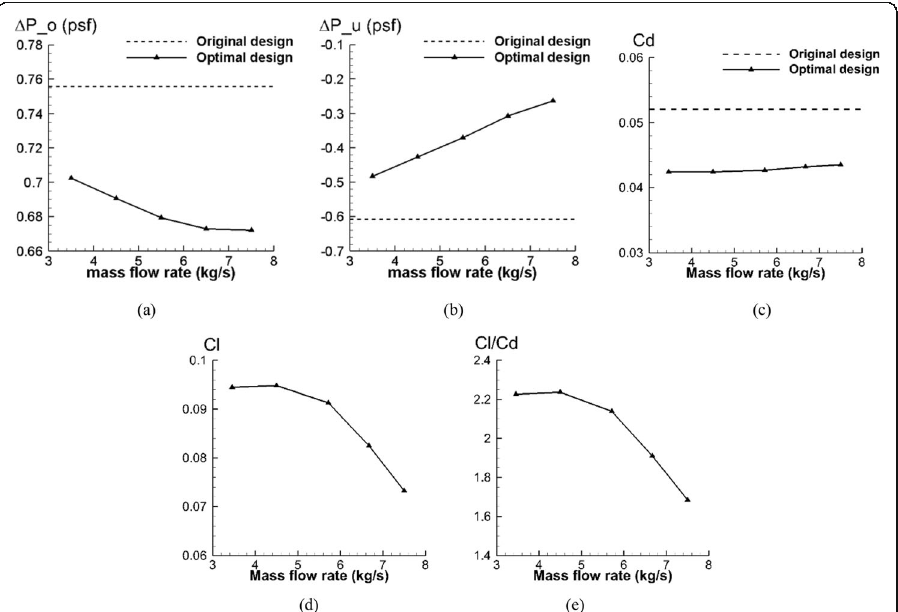
Fig. 13 The ground boom signatures and drag coefficients for the baseline and optimized NACA0008 airfoil with different mass flow rates. a the maximum overpressure vs the mass flow rate; b the maximum underpressure vs the mass flow rate; c the drag coefficient vs the mass flow rate; d the lift coefficient vs the mass flow rate; e the lift-drag ratio vs the mass flow rate